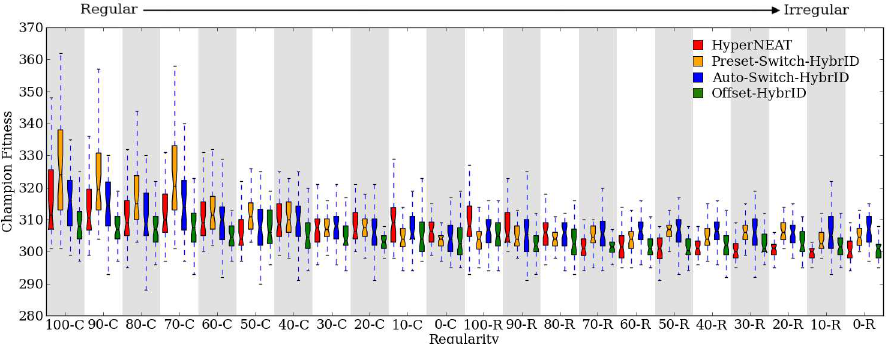
Fig 12. Final fitness per regularity for all methods on the bit mirroring experiment. The fitness of run championsafter 2,000 generationsfor each regularityof the bit mirroring experiment.